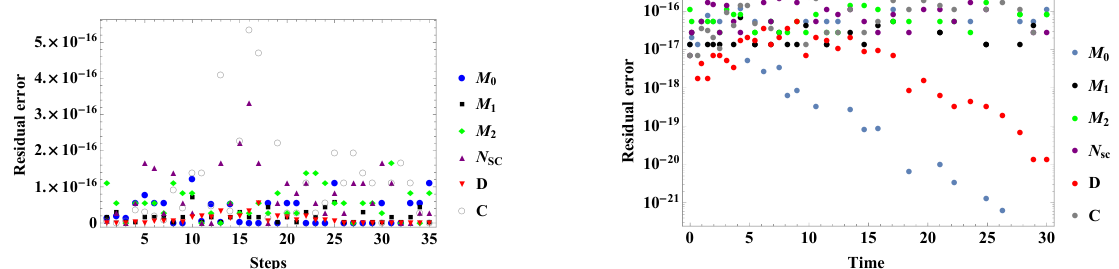
Figure 2. Residual error for the step and time of the numerical method in the SMNR model.